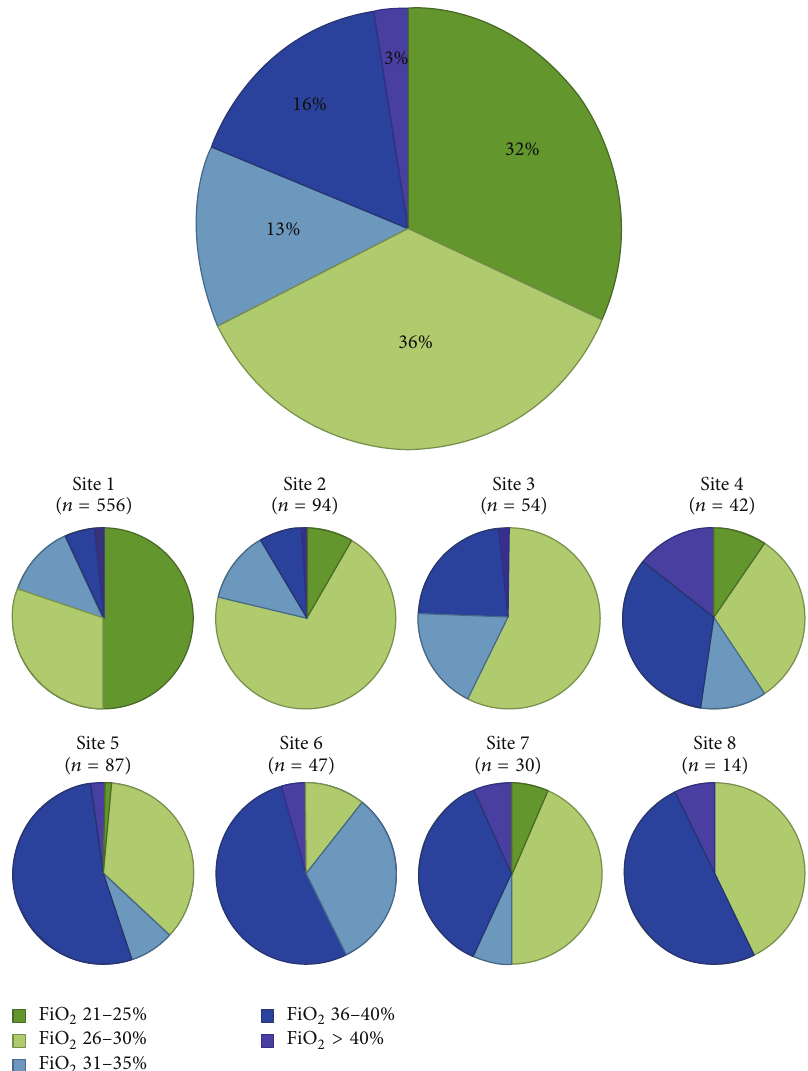
Figure 2: Distribution of fraction of inspired oxygen (FiO 2 ) ranges overall and across sites. The large pie graph in this figure depicts the overall distribution in FiO 2 values from all spontaneous breathing trials (SBTs) with available data for oxygenation. The series of small pie graphs represent the centre-specific distributions, allowing comparison across sites. Values are expressed as % proportion of SBTs. 𝑁 values represent the number of SBTs at each site with available